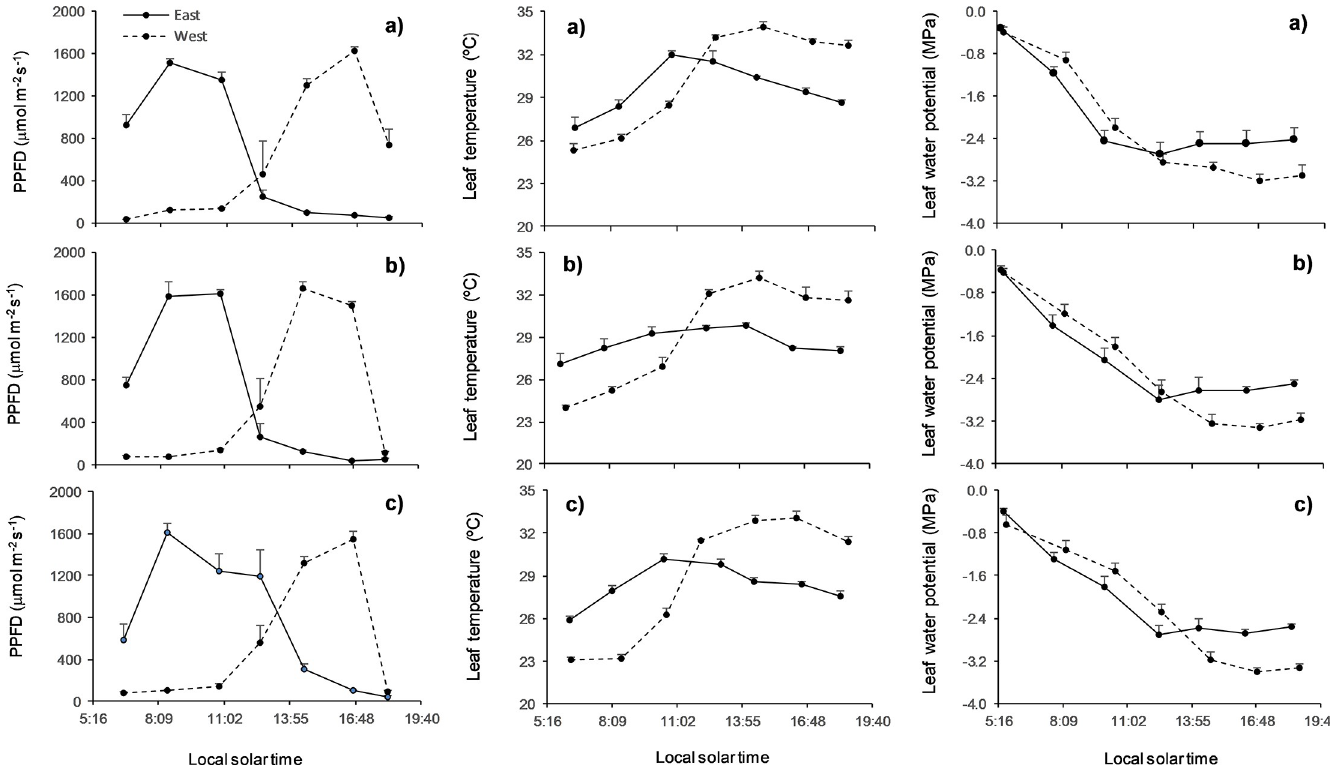
Fig 1. Diurnal changes in photosynthetic photon flux density (PPFD) incident on leaf surfaces, leaf temperature and leaf water potential for the two canopy orientations in Q . faginea (a), Q . suber (b) and Q . ilex (c). Data are represented as mean + SE (n = five trees).